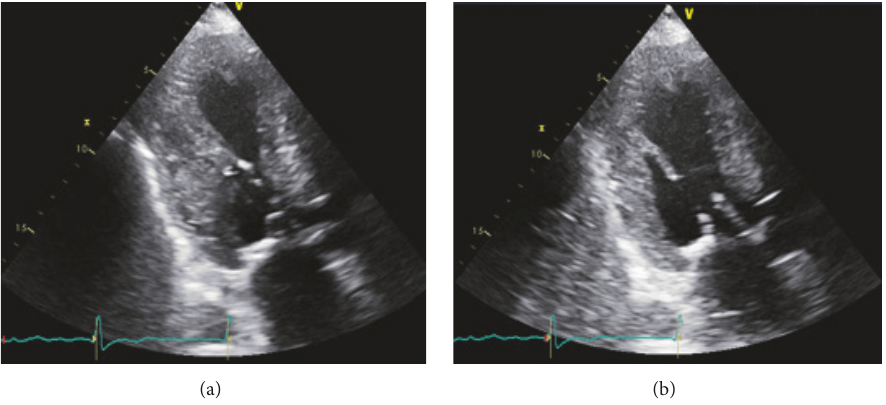
Figure 3: (a) and (b): echocardiogram on day of admission showing the apical ballooning typical of TC in systole and diastole, respectively.